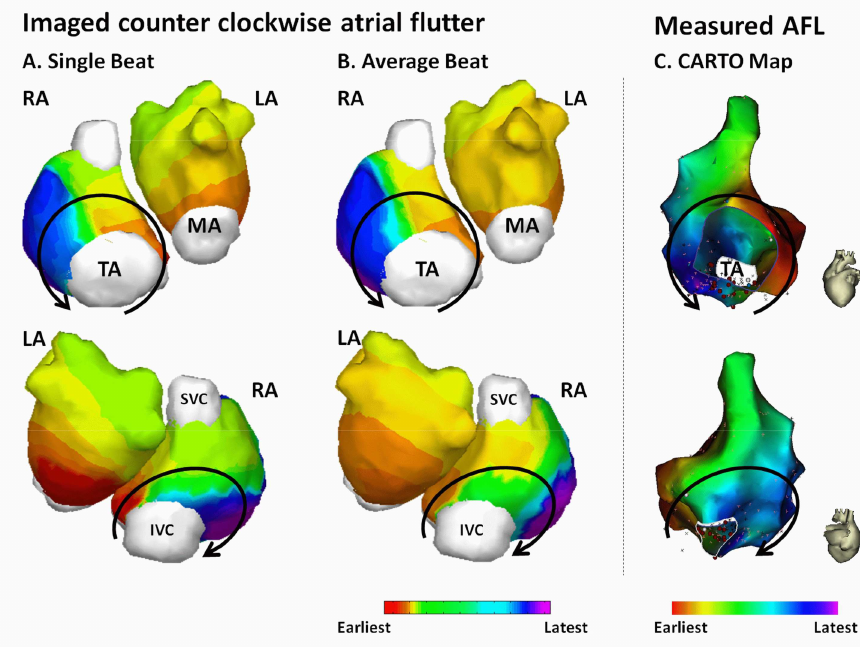
Fig 5. Activation maps for patient AL2. (A) Noninvasively imaged AFL reentry circuit from one single beat. Solid black lines represent propagation wavefronts in RA. (B) Average AFL reentry circuit. (C) CARTO activation map. AFL = Atrial flutter; IVC = Inferior vena cava; LA = Left atrium; MA = Mitral annulus; RA = Right atrium; SVC = Superior vena cava; TA = Tricuspid